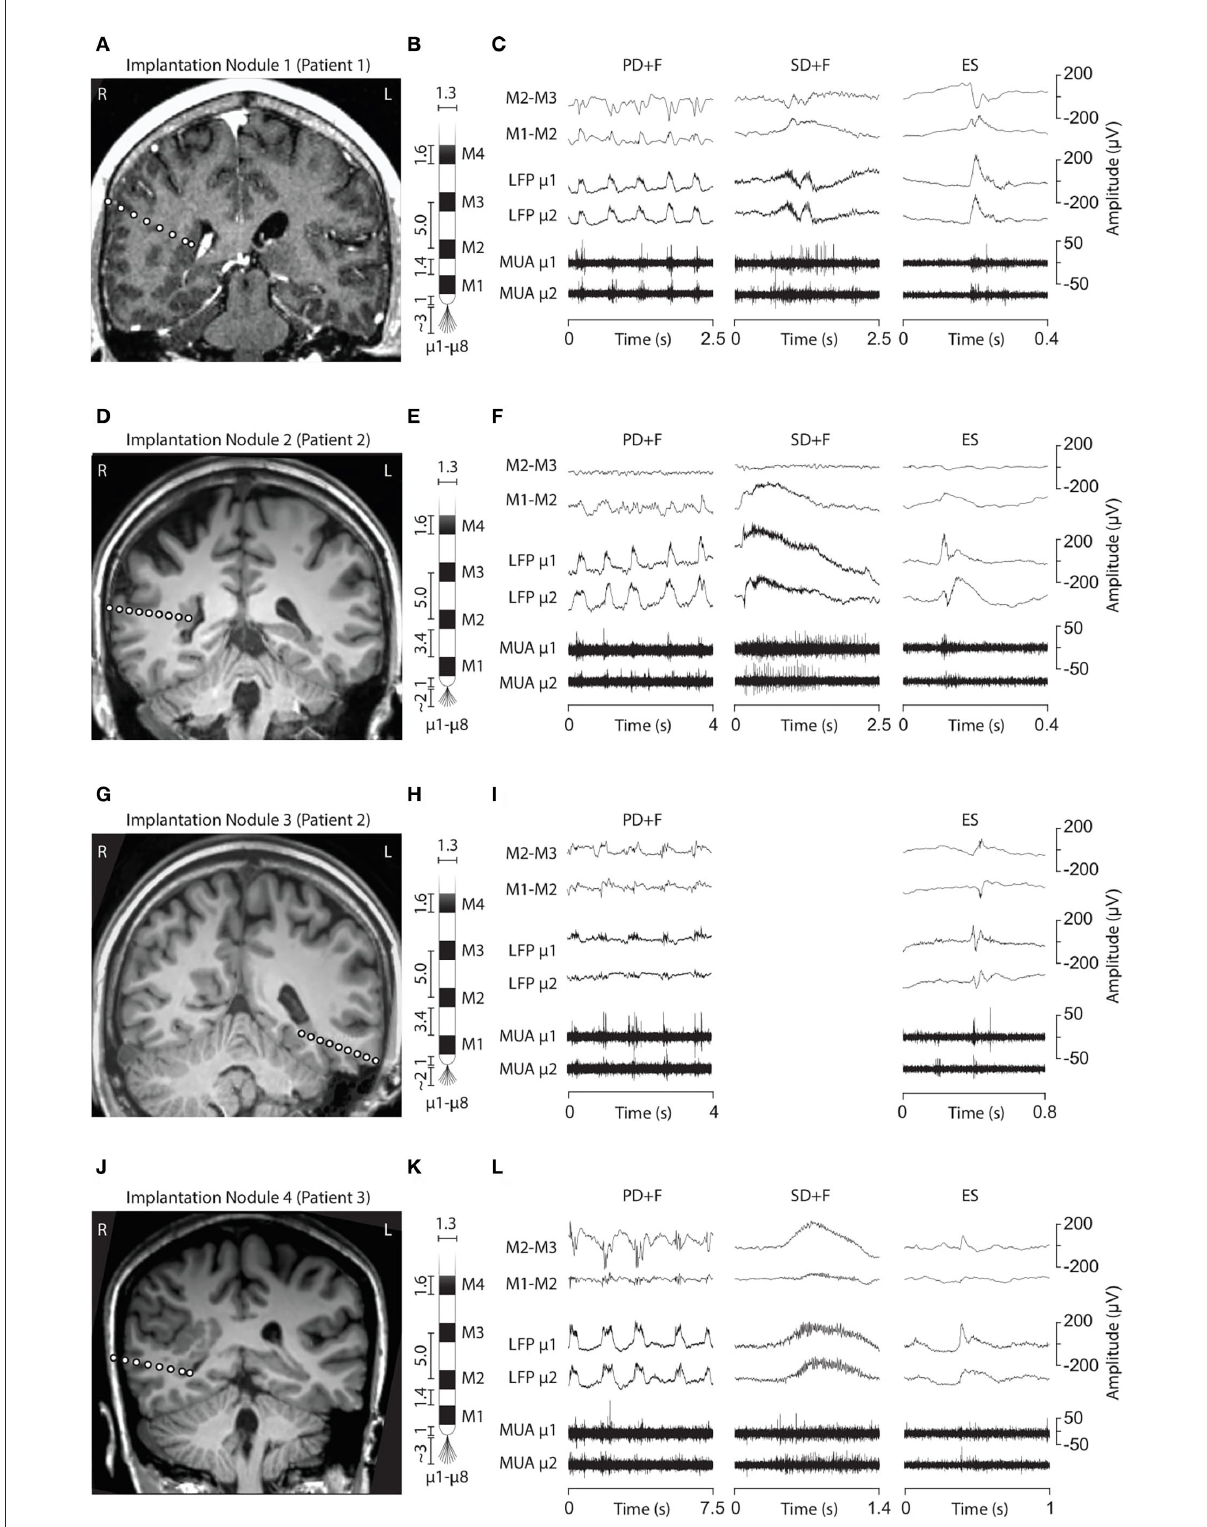
FIGURE1 Electrode implantation into the PNH nodules and interictal LFP patterns. (A, D, G, J) Brain MRI showing the electrode trajectories, exploring the four analyzed nodules (A, Patient 1, Nodule 1; D and G, Patient 2, Nodules 2 and 3; J, Patient 3, Nodule 4). (B, E, H, K) Schematic